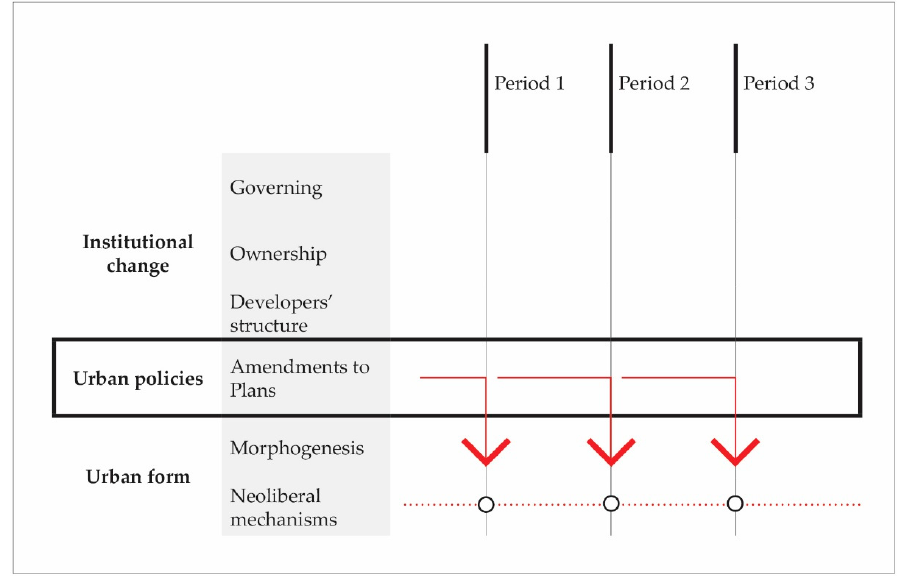
Figure 1. Methodological approach: Chronological case analysis at three levels.